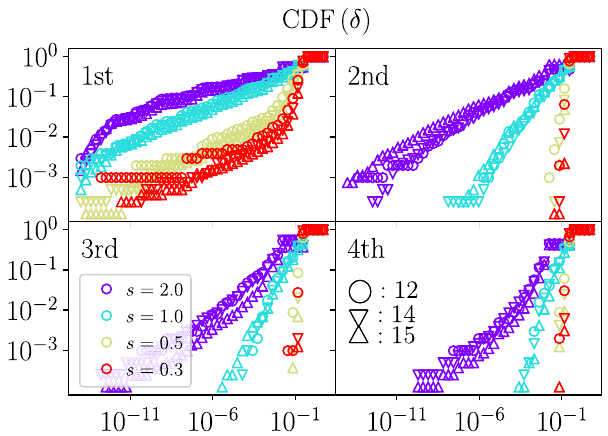
FIG. 10. Energy-resolved cumulative distribution function of δ . We split the eigenstates in four equal-size energy intervals, ordered by growing energy. Most of the eigenstates with small δ are concentrated at low energy. For the largest s ¼ 2 , the count for eigenstates with small δ increases at all